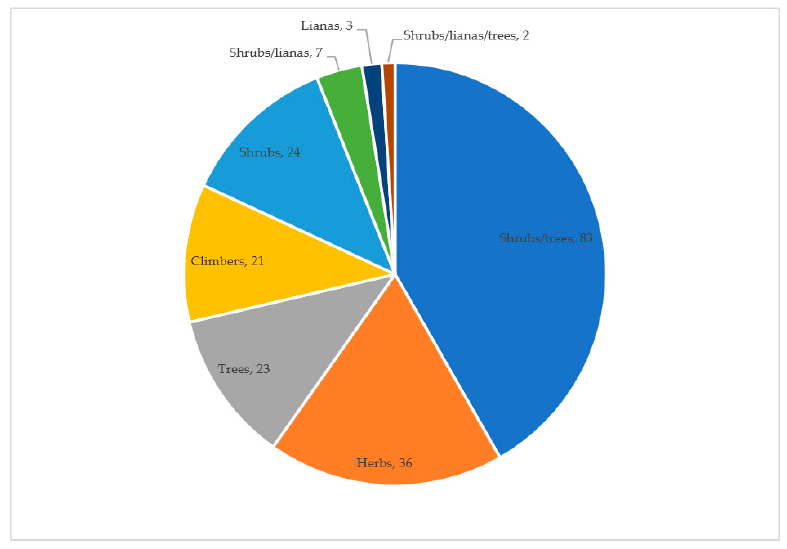
Figure 3. Growth habits of the wild edible plants in Kitui county.